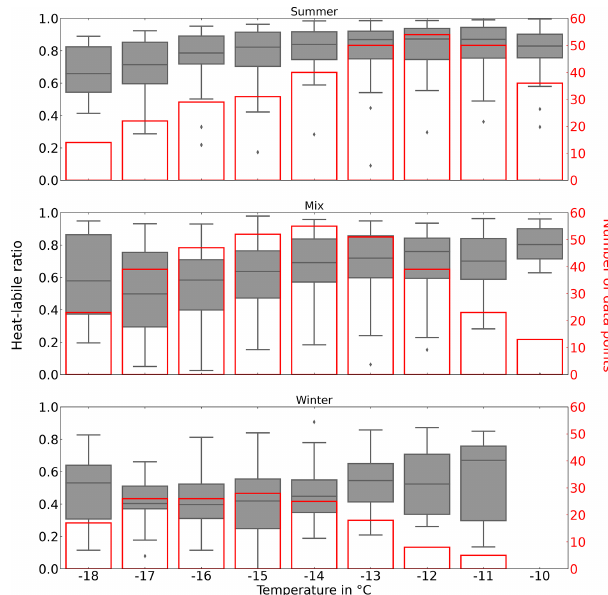
Figure 8. Box plots of the heat-labile ratio for summer, mix and winter type from − 10 to − 18 ◦ C. Bar plots (in red) show the num- ber of data points at each